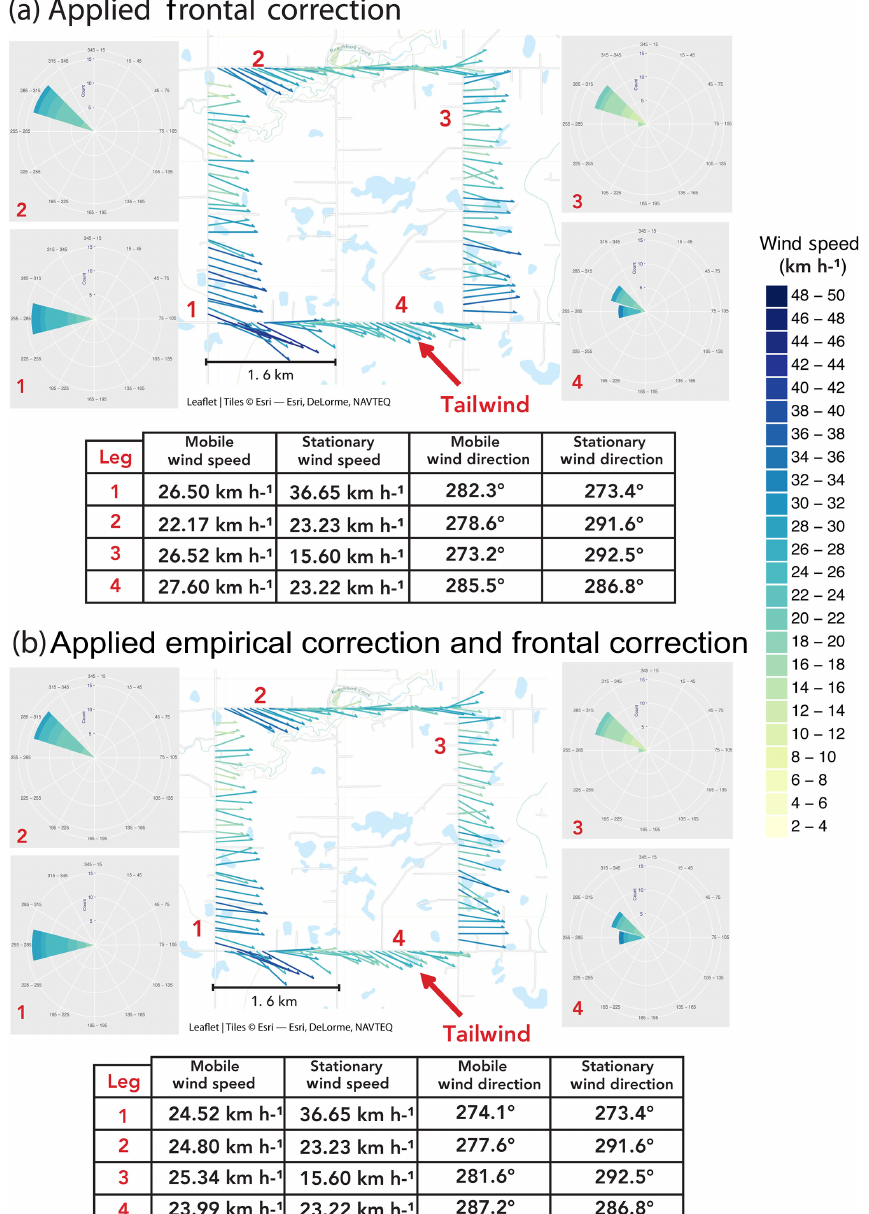
Figure 8. Mobile wind vectors displayed with adjacent stationary wind roses with (a) frontal correction applied to mobile measurements, and (b) empirical correction and frontal correction applied to mobile measurements. The vehicle travelled this route in a clockwise direction. The wind roses show the direction from which the wind is blowing, and the mapped vectors indicate the direction to which the wind is blowing. The table below each plot indicates the averaged stationary and mobile wind speed and wind direction for each leg. Map data: ©Esri – Esri, DeLorme,